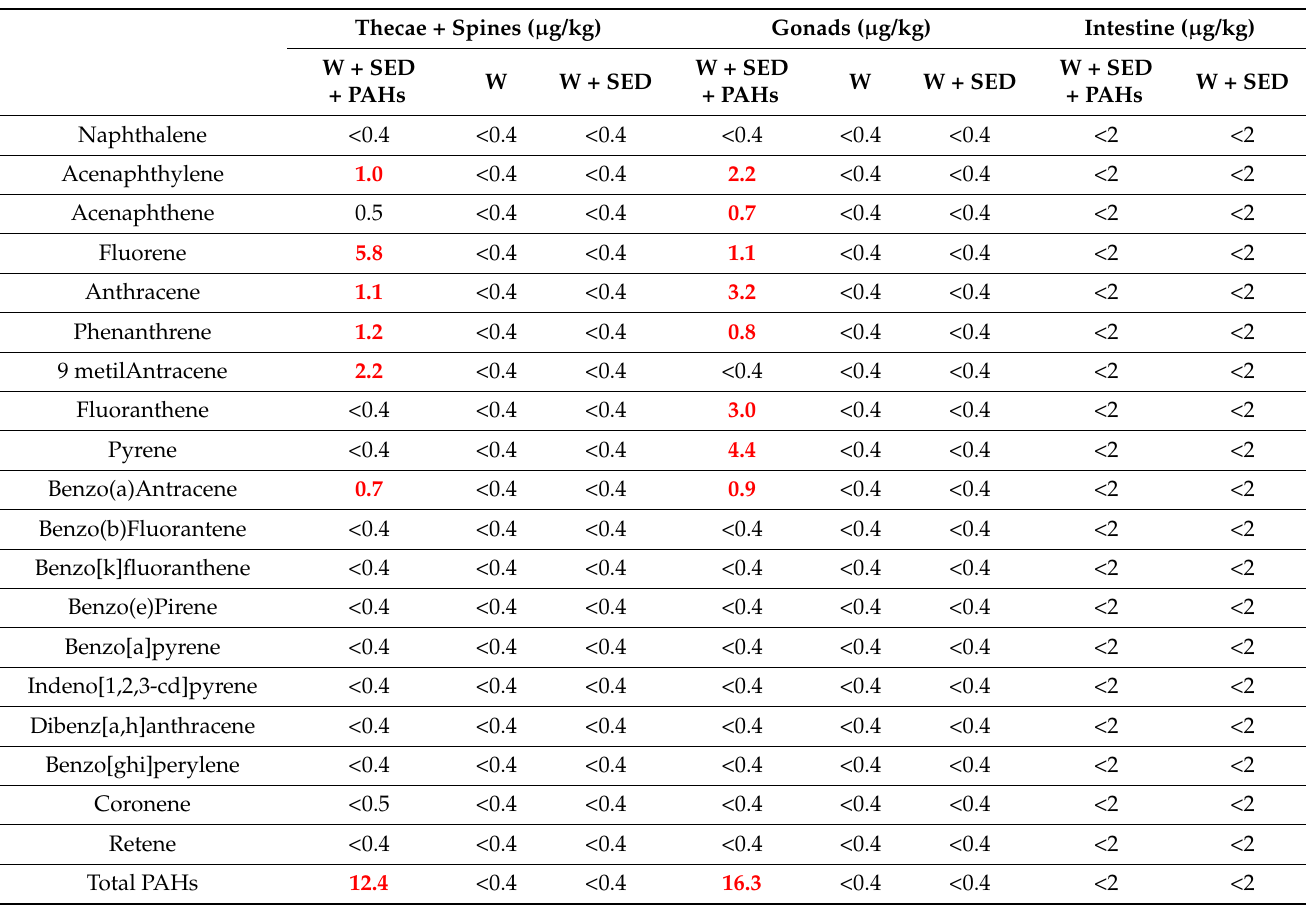
Table 1. Quantity ( µ g/kg) of PAHs detected in thecae (including spines), gonads and gut from adult sea urchin P. lividus in two experimental conditions after two months: W/W + SED and W + SED + PAHs. The values higher than the threshold values are reported in red. PAH total values are also